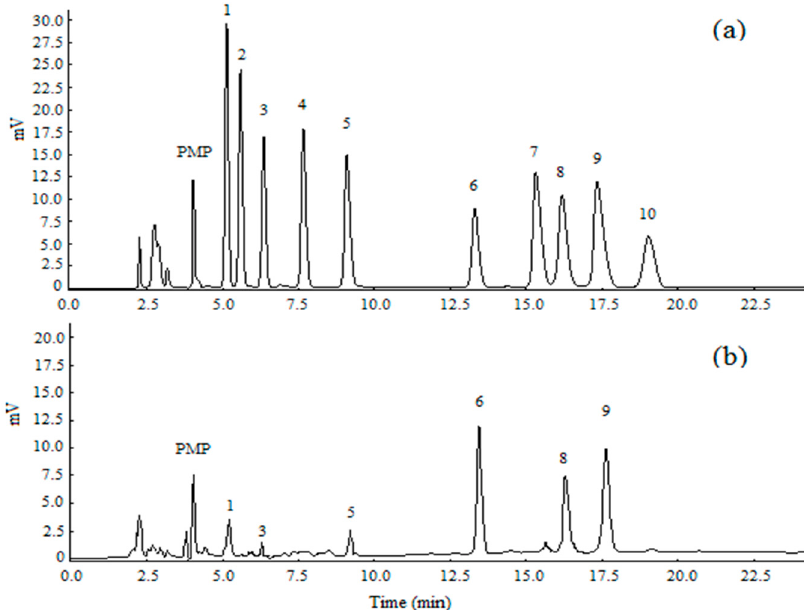
Figure 3. Detection results of samples using an HPLC chromatograms test: ( a ) standard monosaccharides (1—mannose, 2—ribose, 3—rhamnose, 4—glucuronic acid, 5—galacturonic acid, 6—glucose, 7—xylose, 8—galactose, 9—arabinose, 10—fucose); ( b ) monosaccharide composition of Se-TP.